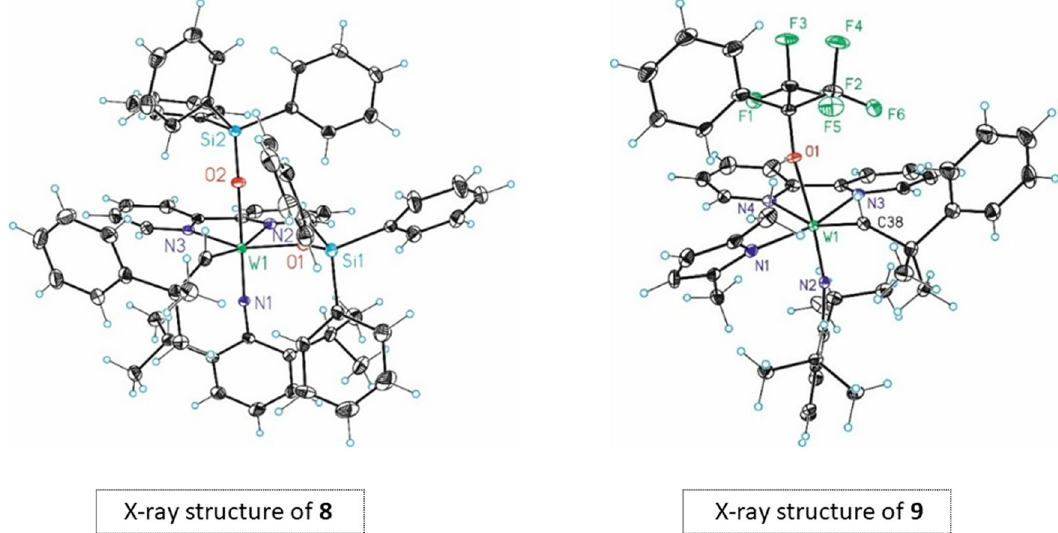
Fig. 6 Structures of the bipyridine adducts 8 and 9 in the solid state. Both structures have distorted octahedral geometry. In both structures, the arylimido ligands are trans to the alkoxide/siloxide ligand, and the neophylidene ligands are syn -oriented (oriented towards the imido ligand).